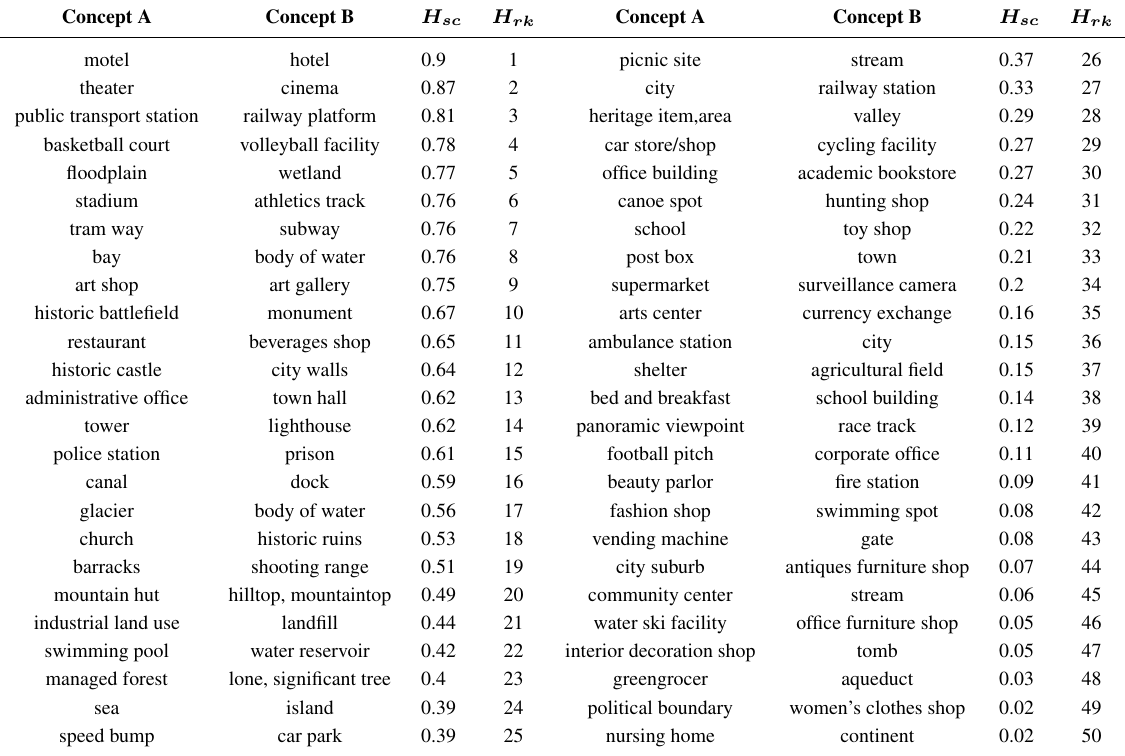
Table 2. Human-generated similarity scores ( H with 0